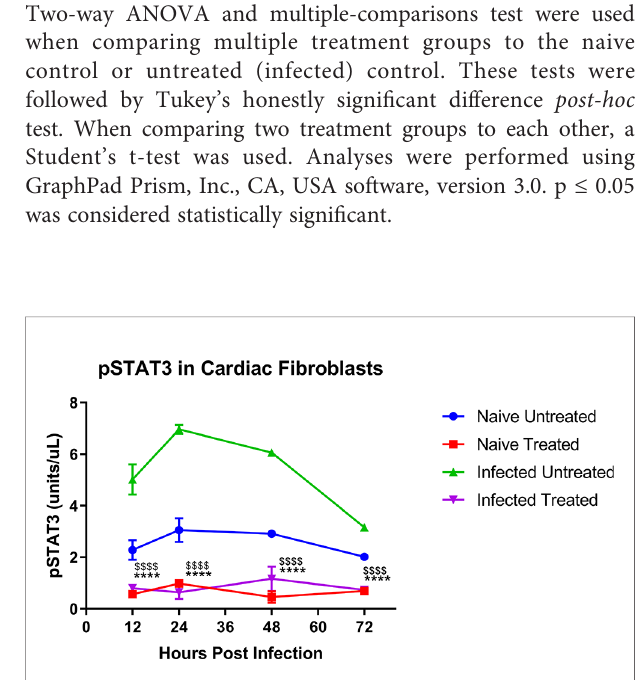
FIGURE 2 | Active signal transducer and activator of transcription-3 (STAT3) concentration in cardiac fi broblast cell culture lysate. Shown are phosphorylated STAT3 (pY-STAT3) concentrations (units/µl, each µl contained 100 µg protein) in cardiac cell culture lysate. Separate cultures of cardiac fi broblasts were infected with one trypomastigote per cell of H1 TCI Trypanosoma cruzi strain or left naive. One each from the infected and naive groups was treated with TTI-101 (20 µM) or media alone. Cells were lysed at 12, 24, 48, and 72 h post infection. Cell lysates were analyzed with ELISA for pY-STAT3 concentration. Depicted are the summary data from two biological and two technical replicates. Error bars represent SD. Data were analyzed with two-way ANOVA; ****p < 0.0001 when comparing TTI- 101-treated cells (purple symbols) to infected untreated cells (green symbols), $$$ $ p < 0.0001 when comparing TTI-101-treated cells (purple symbols) to naive untreated cells (blue